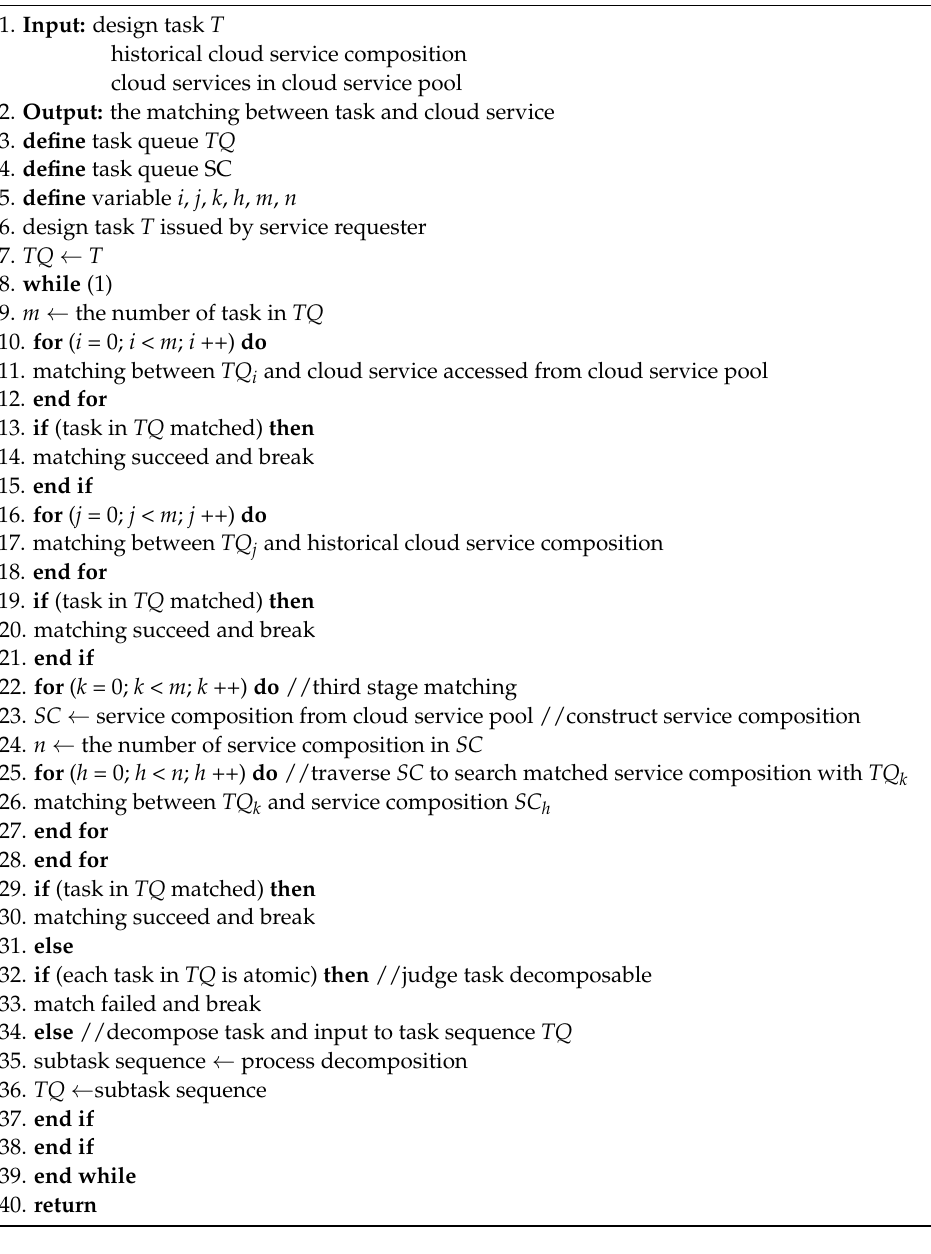
Algorithm 1. The Algorithm of Matching between Task and Cloud